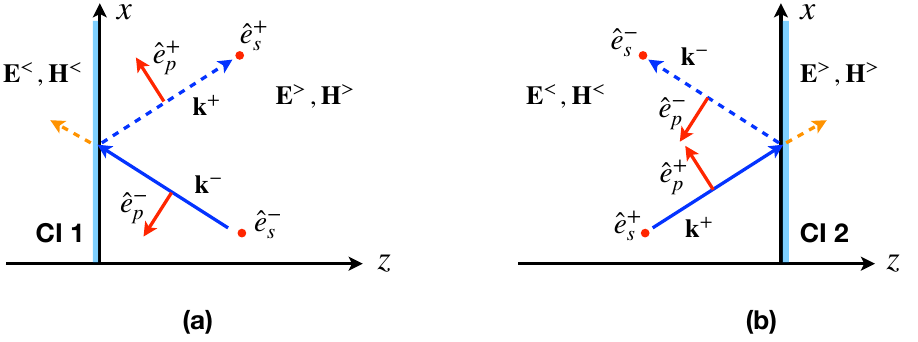
Figure A1. Boundary-value problem for a pair of coplanar Chern insulators (light blue and labeled “CI 1” and “CI 2”) in vacuum: ( a ) ray incident (blue solid arrow) on the left Chern insulator, with k z ) T ; the transmitted ray (orange dashed arrow) has the same wavevector wavevector k − = ( k x ,0, − k and the reflected ray (blue dashed arrow) has the wavevector k + = ( k x ,0, k z ) T . ( b ) Ray incident − on the right Chern insulator, with reflected and transmitted rays. This is a mirror image of the rays in ( a ). E < , H < ( E > , H > ) denote the electric and magnetic fields to the left (right) of a Chern insulator. ˆ k The polarization vectors (red solid arrows) are ˆ e ± p = ˆ e ± s ± ×